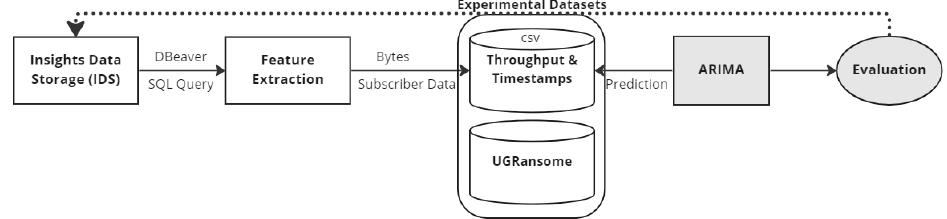
Figure 2. The experimental methodology.